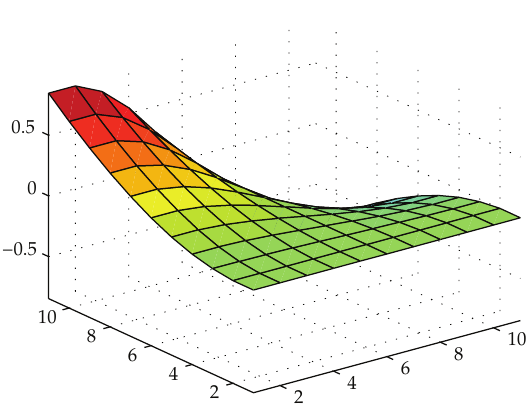
Figure 2: Di ff erence scheme solution for (cid:3) 2.9 (cid:4)